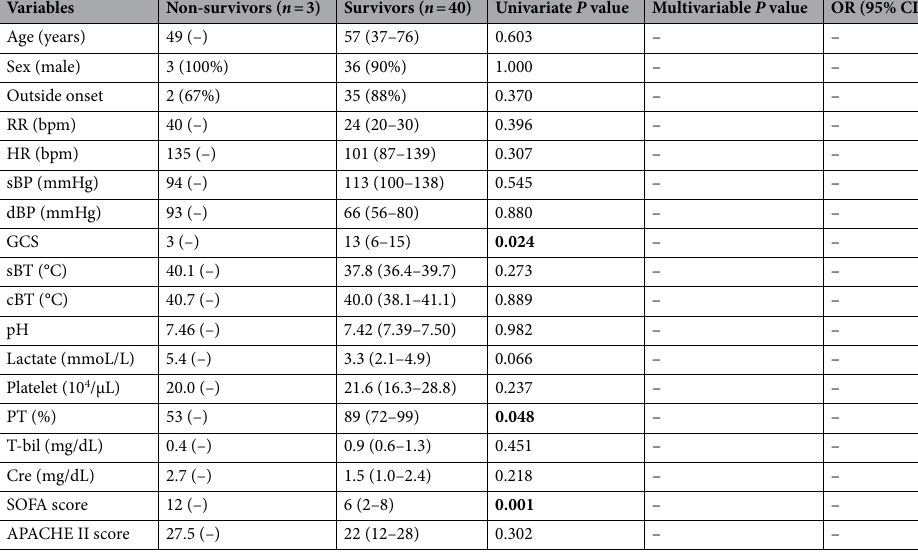
Table 3. Univariate and multivariable comparisons between survivors and non-survivors at 28 days in exertional cases. Values are median (interquartile range) or n (%) of cases. OR odds ratio; CI confidence interval; RR respiratory rate; HR heart rate; sBP systolic blood pressure; dBP diastolic blood pressure; GCS Glasgow Coma Scale; sBT surface body temperature; cBT core body temperature; PT prothrombin time; T-bil total bilirubin; Cre creatinine; SOFA Sequential Organ Failure Assessment; APACHE Acute Physiology and Chronic Health Evaluation. Significant values are in